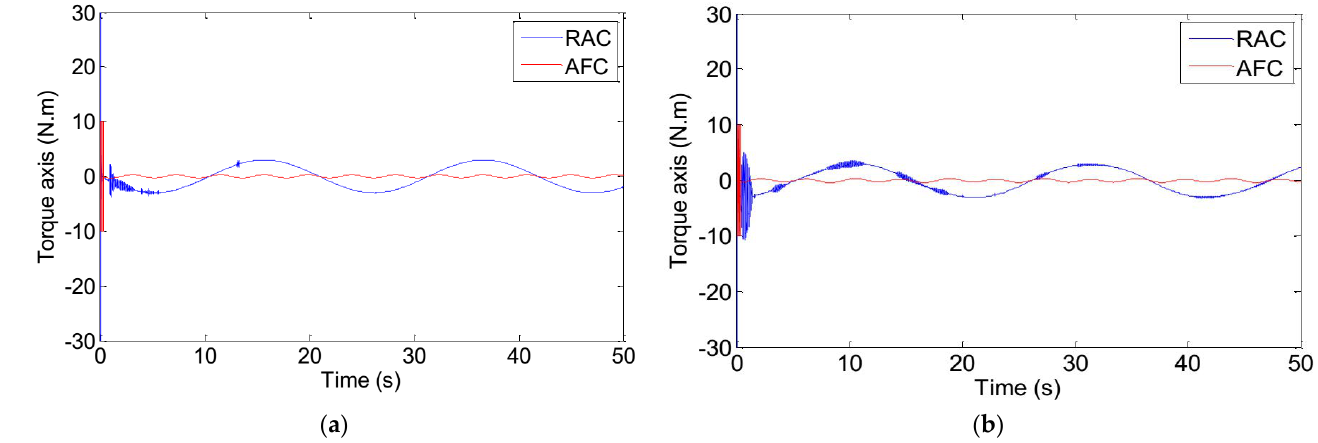
Figure 8. ( a ) First joint control signal and ( b ) Second joint control signal.